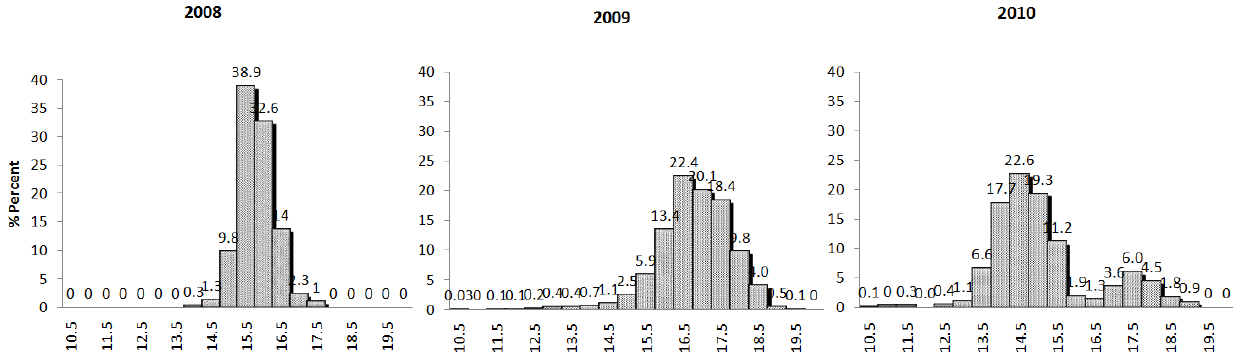
Fig. 2. Catch of carduma ( Cetengraulis mysticetus ) in percentage of individual fish per size interval, for the industrial fishing fleet at the Tortugas Gulf during 2008, 2009 and